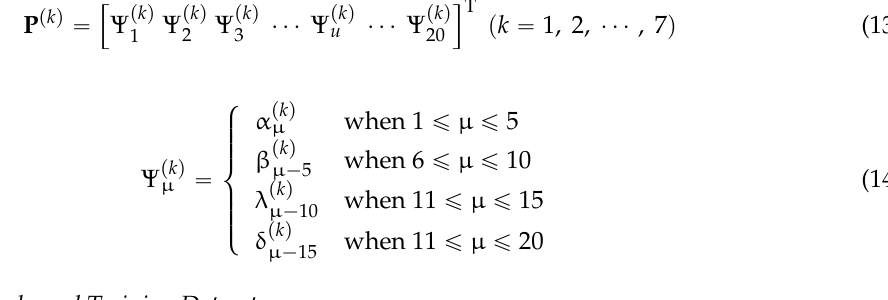
Figure 1. The proposed framework inspired by HVS.